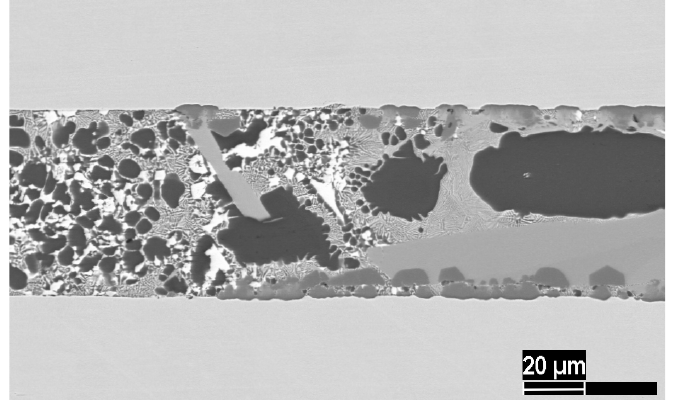
Figure 9. Microstructure of the AISI 304/AISI 304 joint brazed according to the 540 °C/30 min mode, obtained by SEM at 500× magnification.